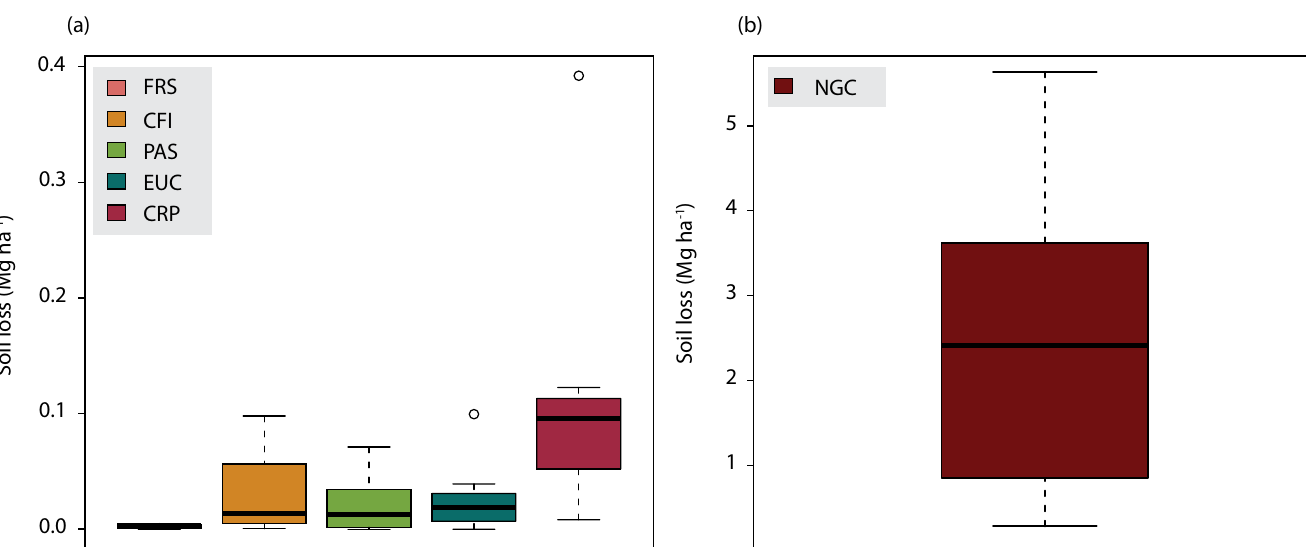
Figure 4. Boxplot of soil loss for: (a) forest (FRS), crop-forest integration (CFI), pasture (PAS), eucalyptus plantation (EUC), soybean and corn crop succession (CRP); and (b) no ground cover (NGC).